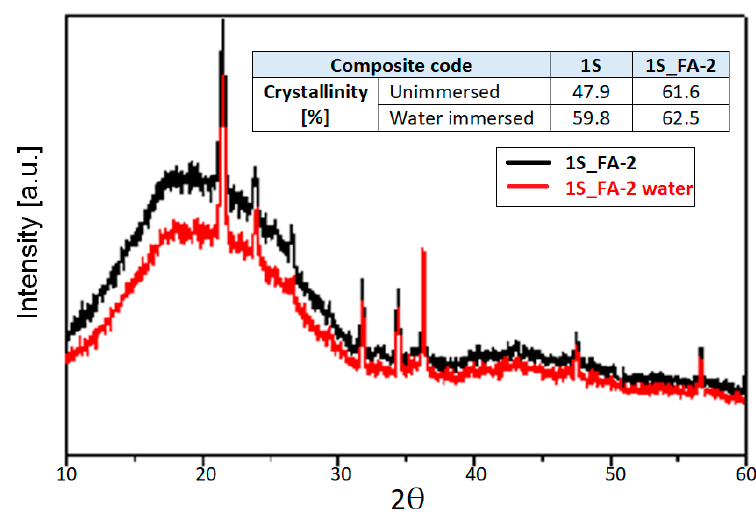
Figure 5. XRD diffractograms of 1S_FA—2 unimmersed and after water immersion.